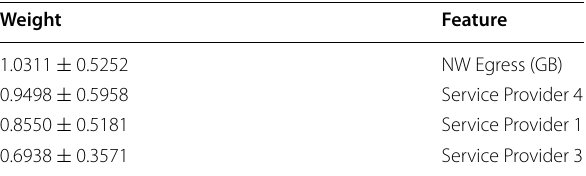
Table 7 Permutation importance feature rank for the cost model of MRS service